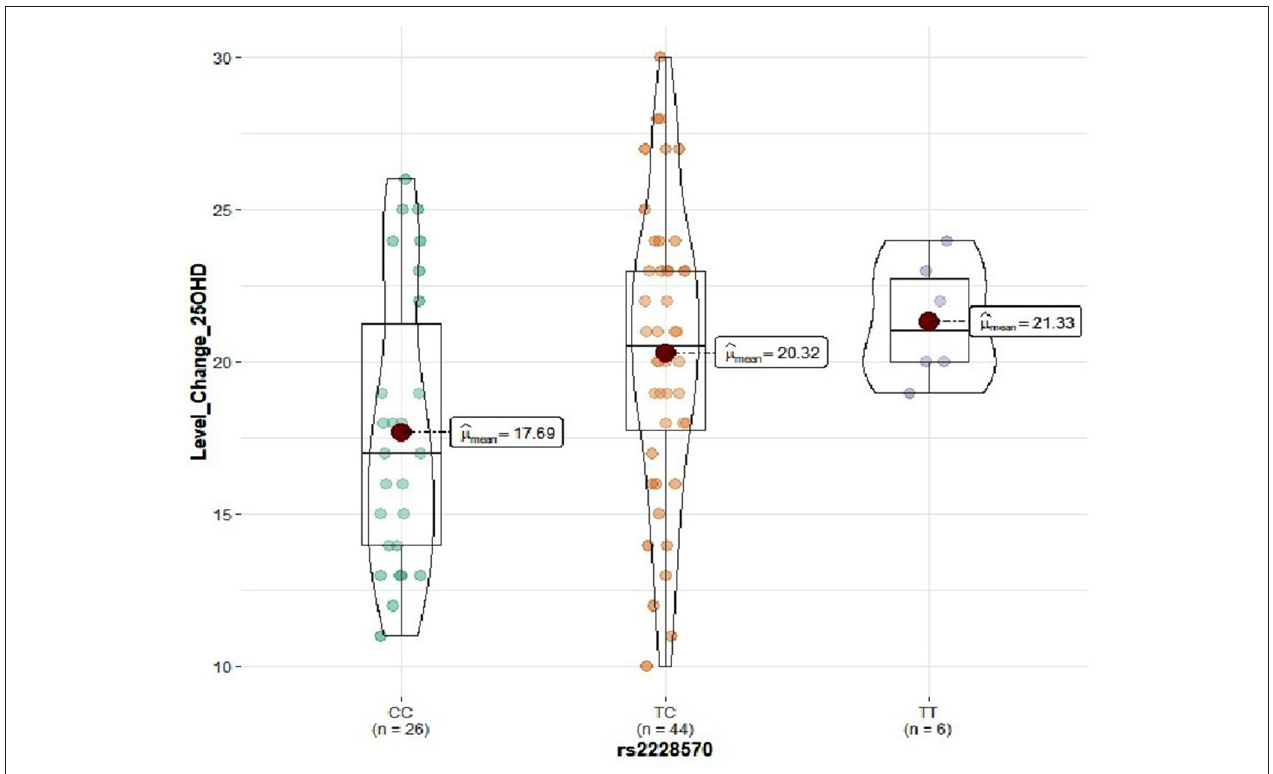
FIGURE 2 | Violin plots displaying the mean 25(OH)D serum level change before and after the intervention in the vitamin D group according to rs2228570 genotype profile.